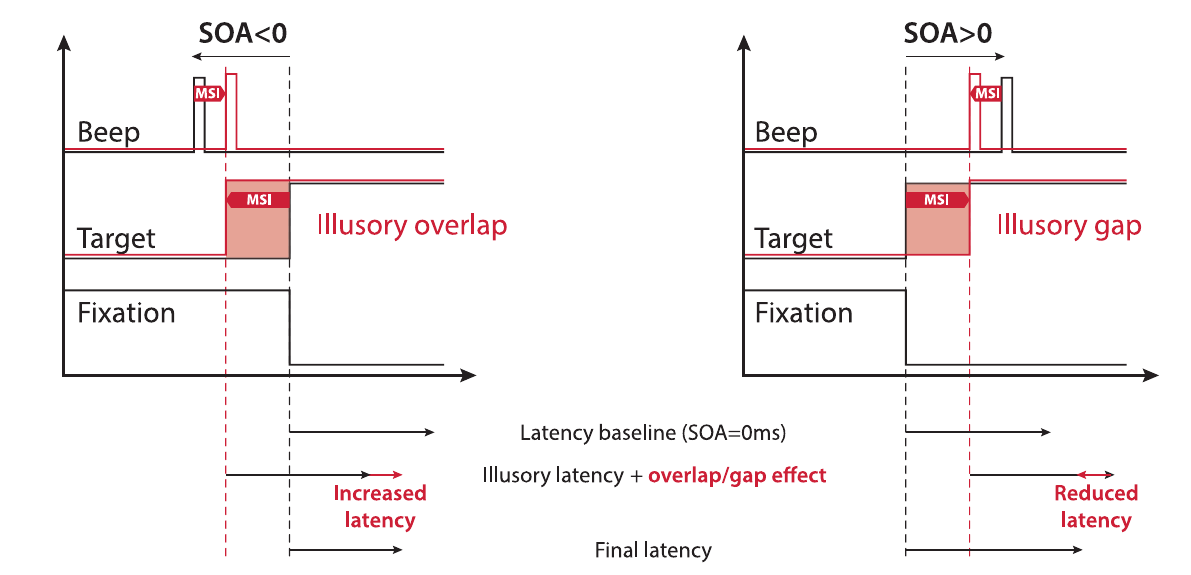
Fig 8. Saccade latency components. Illustration of how temporal multisensory integration could introduce an illusory gap/overlap for positive/negative SOA. This additional effect would have reduced the extent of the multisensory modulation of saccade latencies by reducing the effect of the perceived target onset time